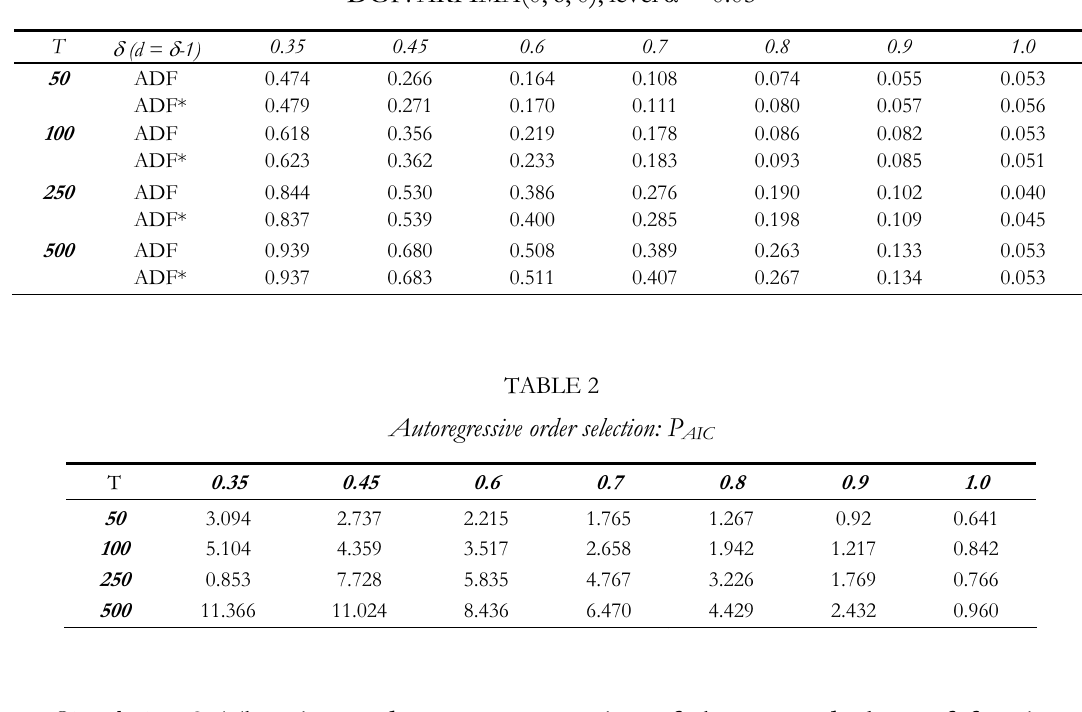
Estimate of power of adf tests